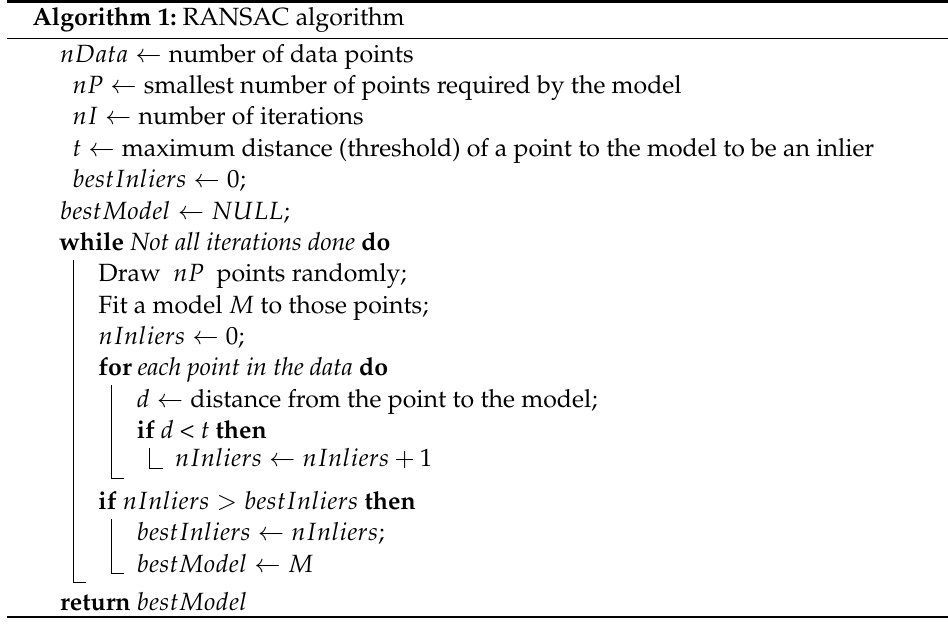
Algorithm 1: RANSAC